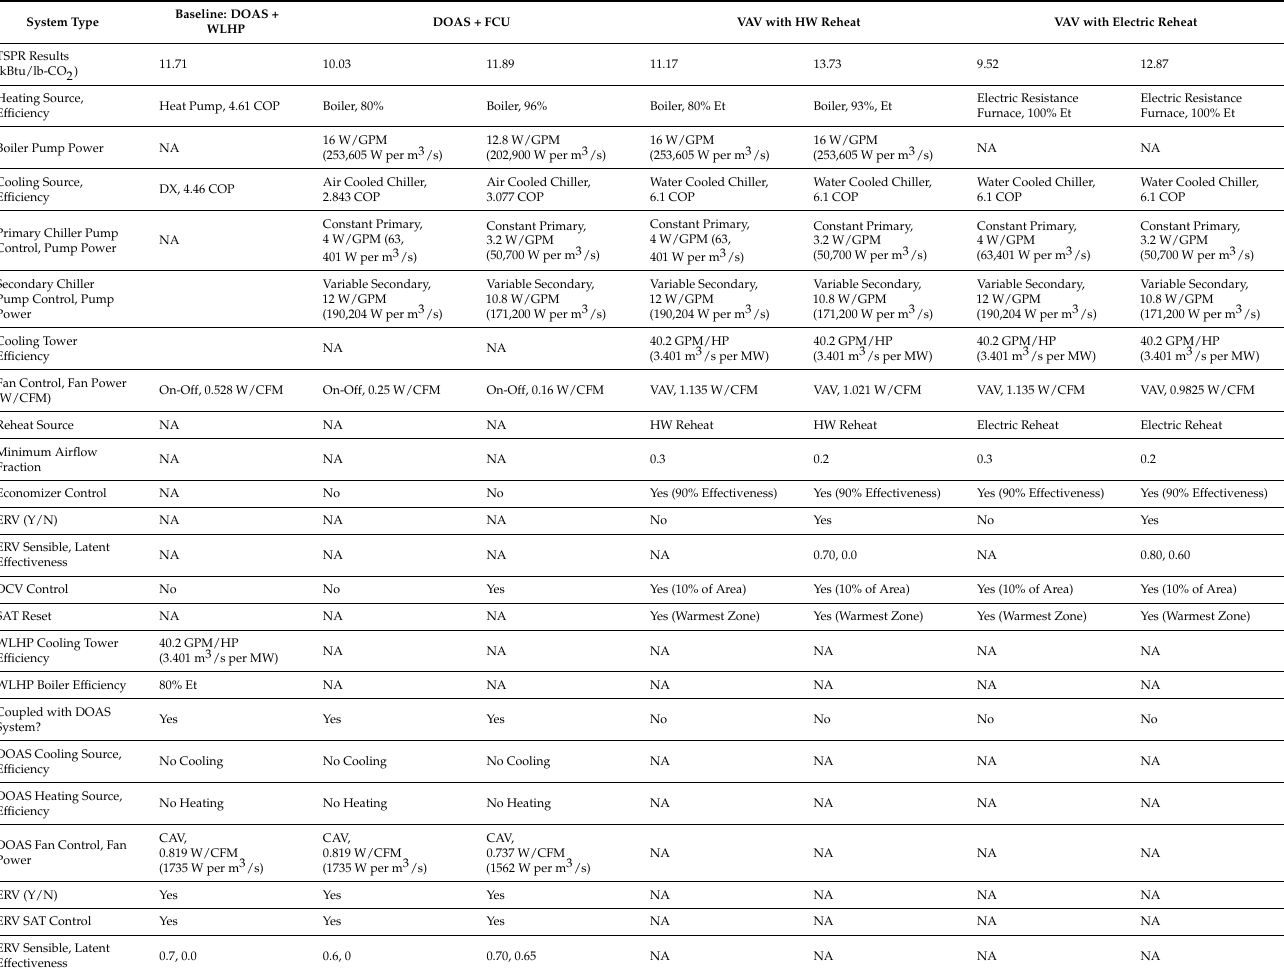
Table 3. System configurations for a large office building analyzed using HVAC System Performance tool.